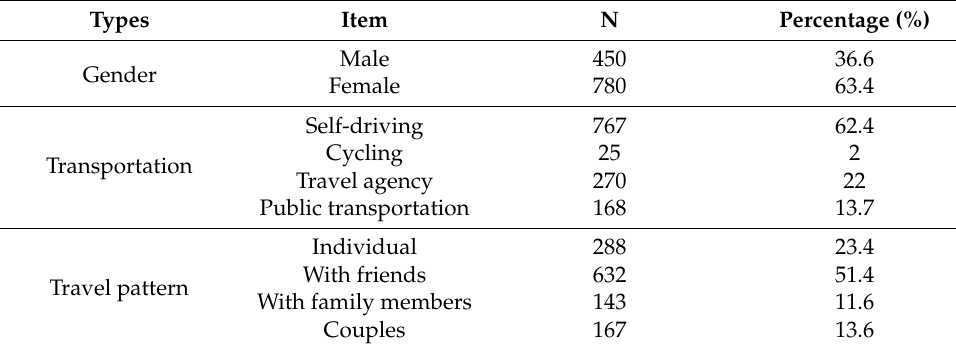
Table 3. Basic information types of the